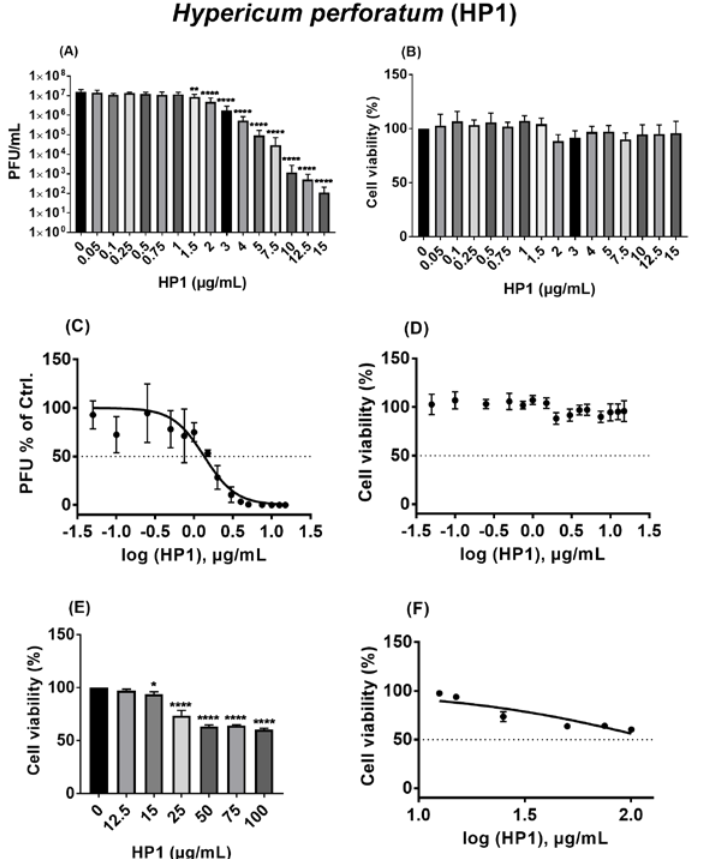
Figure 4. Hypericum perforatum (HP1) acts as an antiviral against ancestral SARS-CoV-2. ( A , C ) Vero cells were seeded overnight, and on the next day, prior to infection (MOI = 0.05), cells were incubated at 37 ◦ C for 1h with infection-DMEM containing either solvent control (DMSO) or HP1. Concurrently, SARS-CoV-2 was incubated for 1 h at room temperature in infection-PBS that contained either DMSO or HP1. After infection (37 ◦ C/1 h), cells were further incubated in infection-DMEM including either DMSO or HP1. After 24 h, virus supernatants were collected and subjected to plaque assay. ( A ) Results are expressed as PFU/mL (mean and s.d.), and one-way ANOVA with Dunnett’s multiple comparisons was done by comparing each value with the control. ( C ) Dose–response curve of the normalized virus titer values as % of solvent control is depicted (mean and s.d.). ( B , D – F ) Vero cells were seeded overnight, and on the next day, cells were incubated for 24 h with infection-DMEM that contained either solvent control (DMSO) or HP1. After incubation, the MTT assay-based cytotoxicity was measured. ( B , E ) Cell viability as % of solvent control is shown (mean and s.d.), and one-way ANOVA with Dunnett’s multiple comparisons was done by comparing each value with the control. ( D , F ) Dose–response curve of the normalized cytotoxicity values as % of solvent control is depicted (mean and s.d.). * for p ≤ 0.05, ** for p ≤ 0.01, and **** for p ≤ 0.0001 .